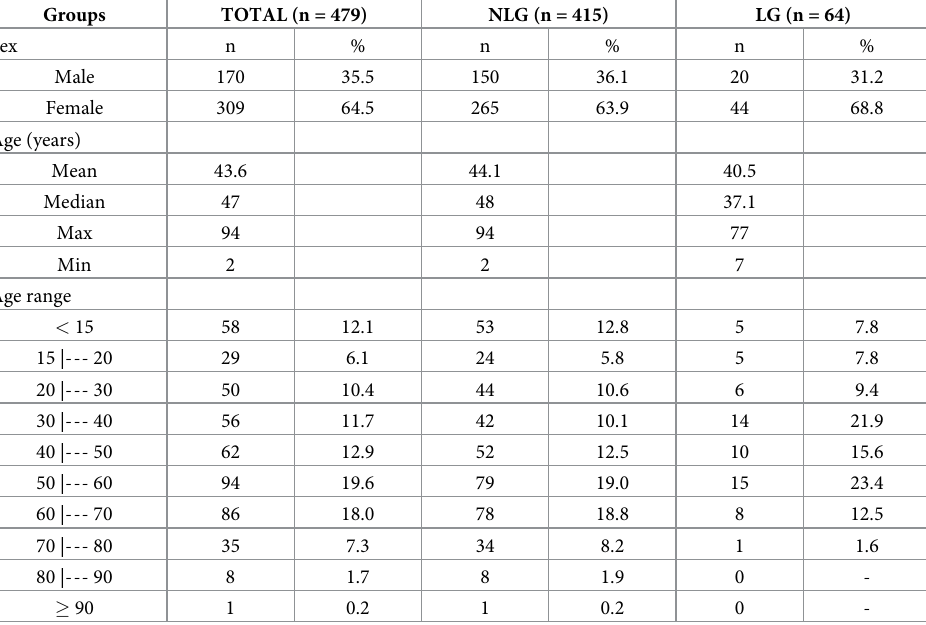
was � 3 in both groups. Notable crossings among marked questions of new leprosy patients were Q2xQ7 (43.7%), Q1xQ2 (35.9%), Q1xQ7 (31.2%), Q4xQ7 (23.4%), Q2xQ4 (21.9%), Q7xQ8 (17.2%), Q1xQ4 (15.6%) (Table 2). All two-by-two crossings showed differences in rel- ative risk (RR) for leprosy ranging from 3 to 5.8 compared with NLG. Among 179 LSQ- respondents, only 4 leprosy new cases were diagnosed (2.2% NCDR). The probability of finding one new leprosy case among LSQ+ individuals was 15 times greater than among LSQ-, with an RR of 8.95 (95% CI 3.3–24.2, p < 0.0001). In total, 479 (14.8%) individuals were evaluated and 64 new cases were diagnosed, a 13.4% NCDR within the Jardino´polis population sample. LG (n = 64) and NLG (n = 415) groups were established and characterized in Table 3. Concerning the leprosy patients’ clinical aspects, all were multibacillary, 100% presented dysesthesia in macular cutaneous areas (Fig 2), and 71.9% presented some peripheral nerve impairment; other aspects are presented in Table 4. In NLG, 335 (80.8%) had BCG vaccination scars, similar to LG (52; 81.3%) (Table 4). Table 3. Demographic characterization of Leprosy and Non-Leprosy groups. Groups TOTAL (n =